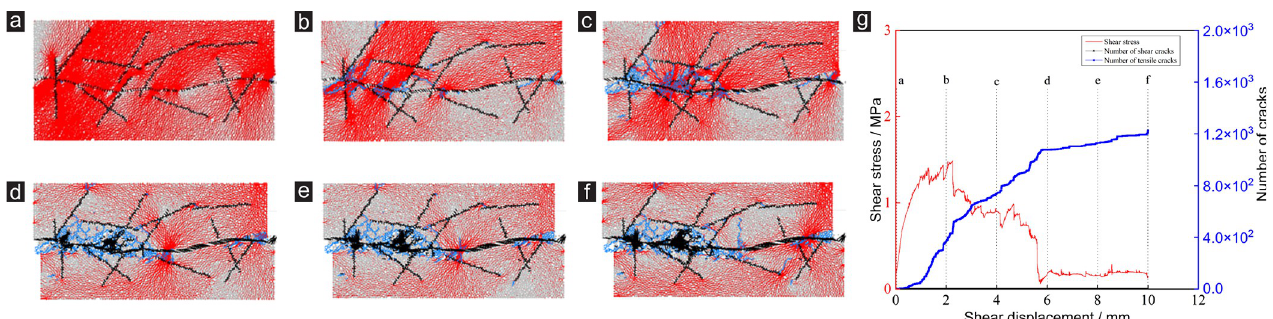
Fig 8. Evolution process of internal stress in specimens for γ = 12. (a) μ = 0.2 mm, (b) μ = 2 mm, (c) μ = 4 mm, (d) μ = 6 mm, (e) μ = 8 mm, (f) μ = 10 mm, (g) shear stress-shear displacement and number of cracks-shear displacement.